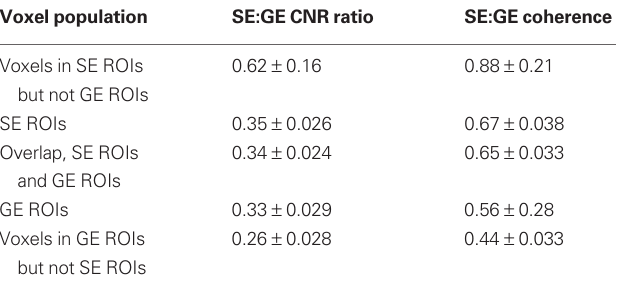
Table 2 | Ratios of contrast-to-noise ratio for ge and Se localizers in different voxel populations.